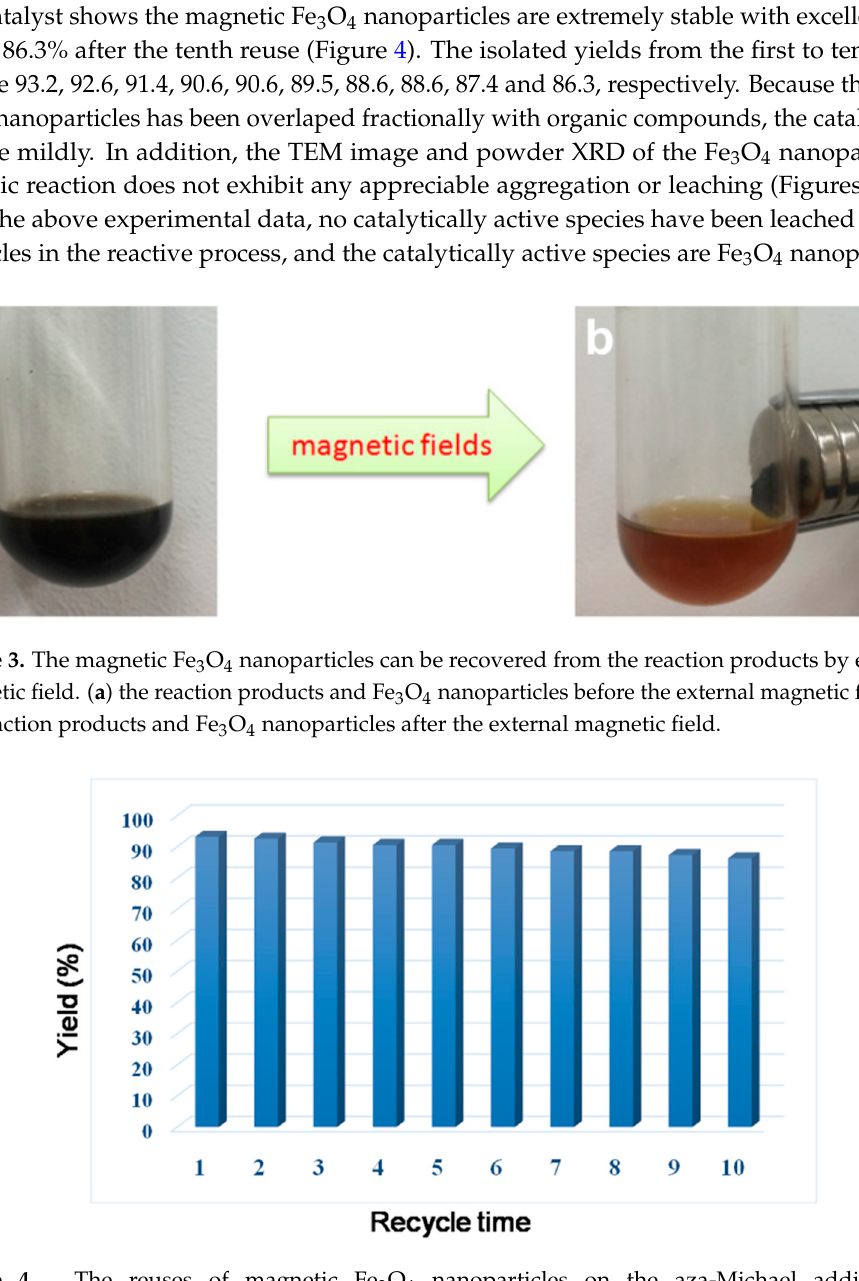
Figure 4. The reuses of magnetic Fe 3 O 4 nanoparticles on the aza ‐ Michael addition of N ‐ phenylacrylamide with morpholine.